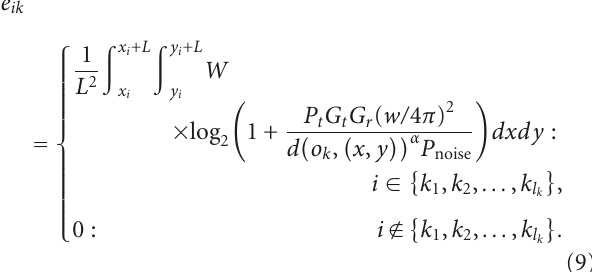
(QoS) requirements of individual links. In other words, the deployment of RNs has to consider not only the coverage but also the QoS performance with intelligent channel